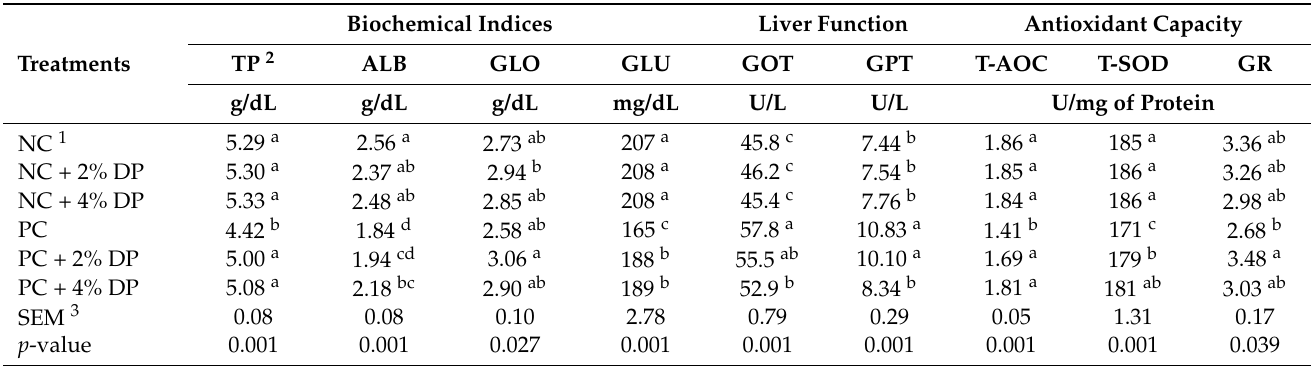
Table 4. Effect of adding two levels of date pits (DP) as aflatoxin adsorbent to aflatoxin B1 (AFB1)- contaminated diets on blood serum parameters of broilers at 30 d.